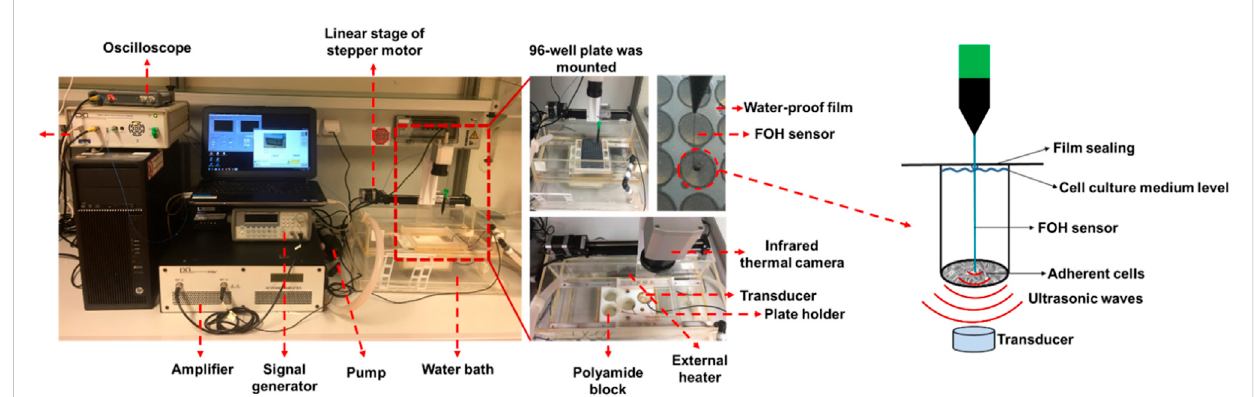
FIGURE 1 In vitro focused ultrasound (FUS) apparatus displaying experimental con fi guration for cavitation detection and FUS treatment. The FUS system is composed of a Perspex ® water bath compartment with pump and adjustable heater, a customized single-element FUS transducer at 1.467 MHz, a small polyamide block worked to detachably accommodate the transducer, a 3D-printed plate holder, and a stepper motor to move the 96-well plate. The continuous ultrasound waves were emitted from the transducer using the FUS signal generator and a radiofrequency power ampli fi er. A 96-well µclear plate was used for the FUS treatment of cells. To retain the cells in a sterile environment, the plate was protected with a water-proof fi lm. A fi ber- optic hydrophone system connected to an oscilloscope was utilized to calibrate the transducer and measure the dose of cavitation that occurs on the adherent cells. The right diagram shows the measurement position of the FOH sensor and the focused ultrasonic action site. A thermal camera was mountedtomeasurethetemperatureinrealtime.TheLabViewapplicationwasutilizedtocontroltheFUStreatmentusingafeedbacklooptothethermal